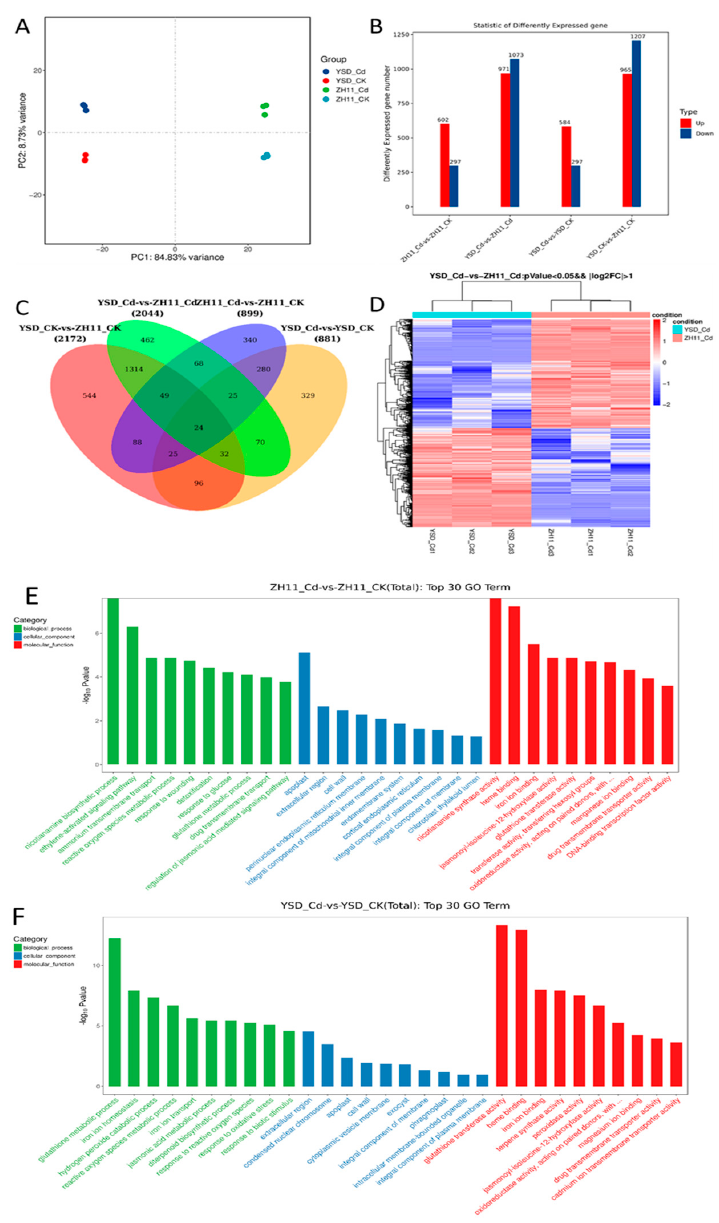
Figure 5. Analysis of transcriptome data from YSD and ZH11 roots. After 4 weeks of hydroponics, rice seedlings were treated with 0, 10 μ M Cd for 3 days, and roots were taken for RNA_seq analysis. ( A ) Principal component analysis. ( B ) Number of up_ and down_regulated differentially expressed genes. ( C ) Venn diagram analysis of differentially expressed genes, ( D ) Heat map of differentially expressed genes. ( E ) GO annotation of differentially expressed genes in response to Cd stress in the roots of ZH11. ( F ) GO annotation of differentially expressed genes in response to Cd stress in the roots of YSD.